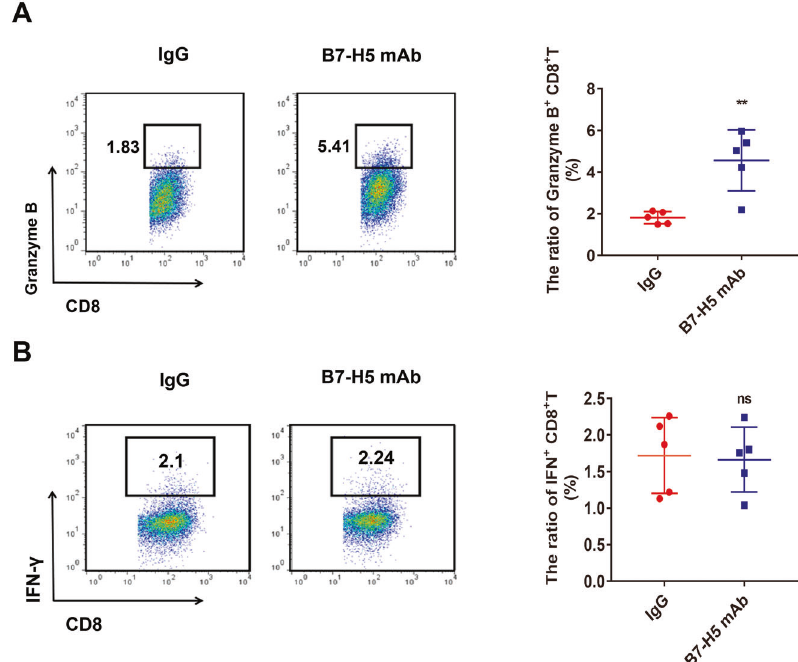
Fig. 5 B7-H5 blockade affects the cytokine expression of CD8 + T cells in vitro. A , B The intracellular Granzyme B (A) and IFN- γ (B) expression in CD8 + T cells after treatment with IgG or B7-H5 mAb were detected by fl ow cytometry. A representative image is shown. The experiments were performed in triplicate. Values are expressed as means (SD). ** P < 0.01.